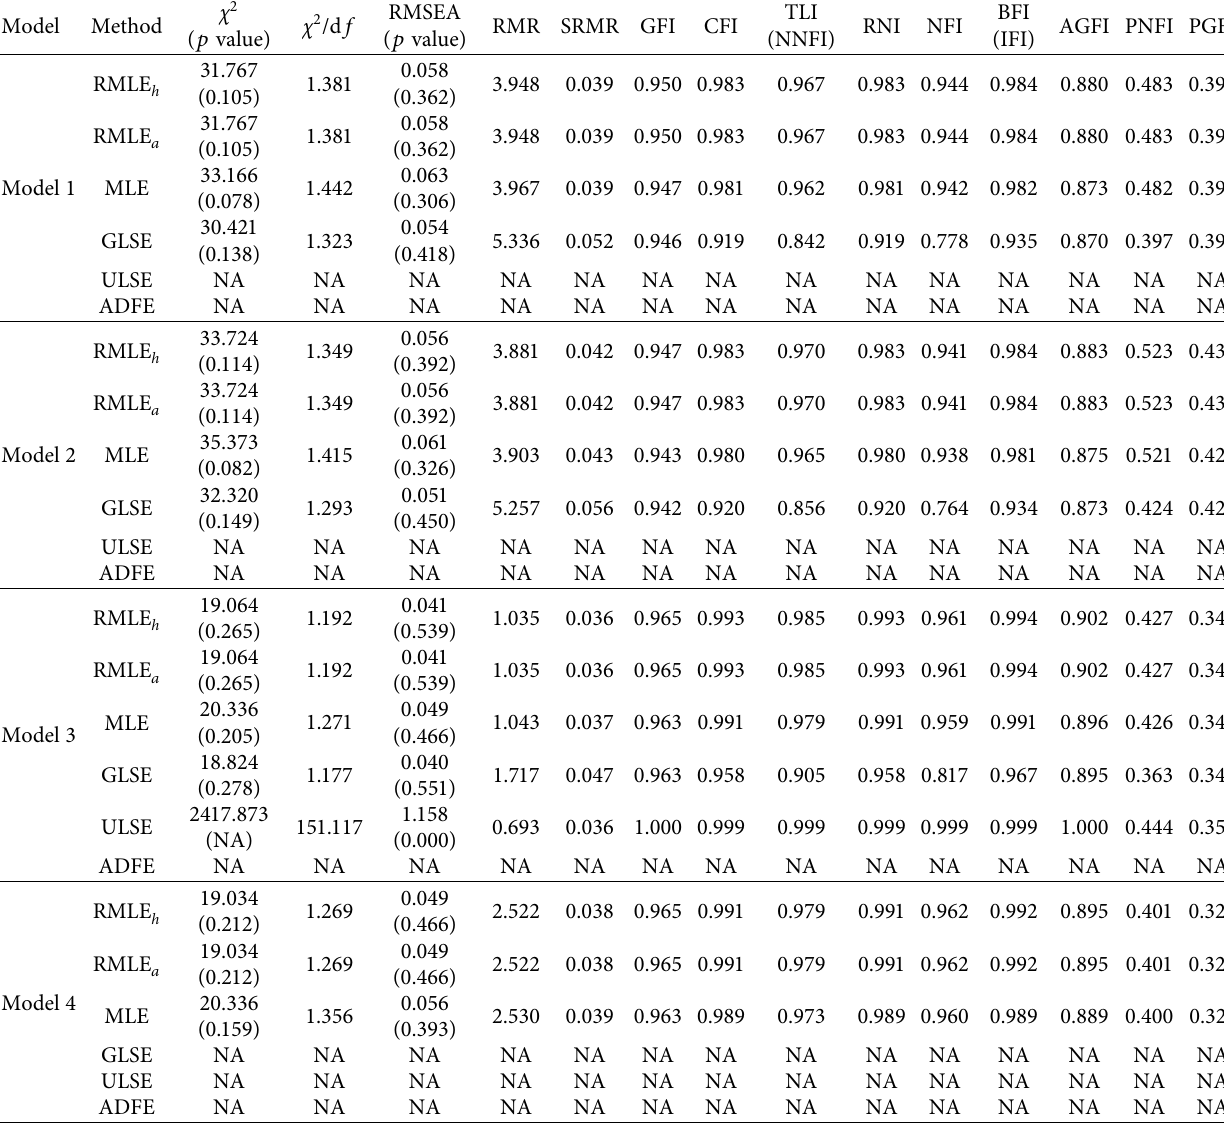
Table 3: Goodness-of-fit measures for the